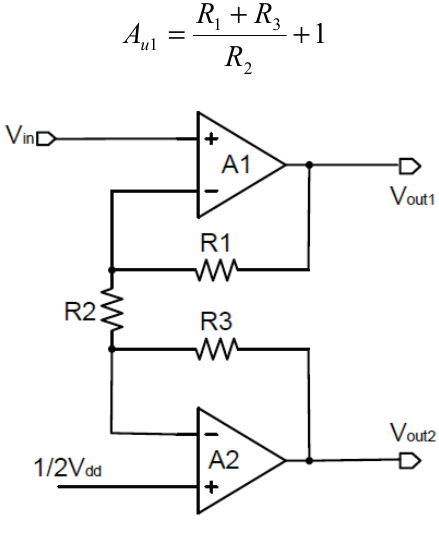
Figure 6. Instrumentation